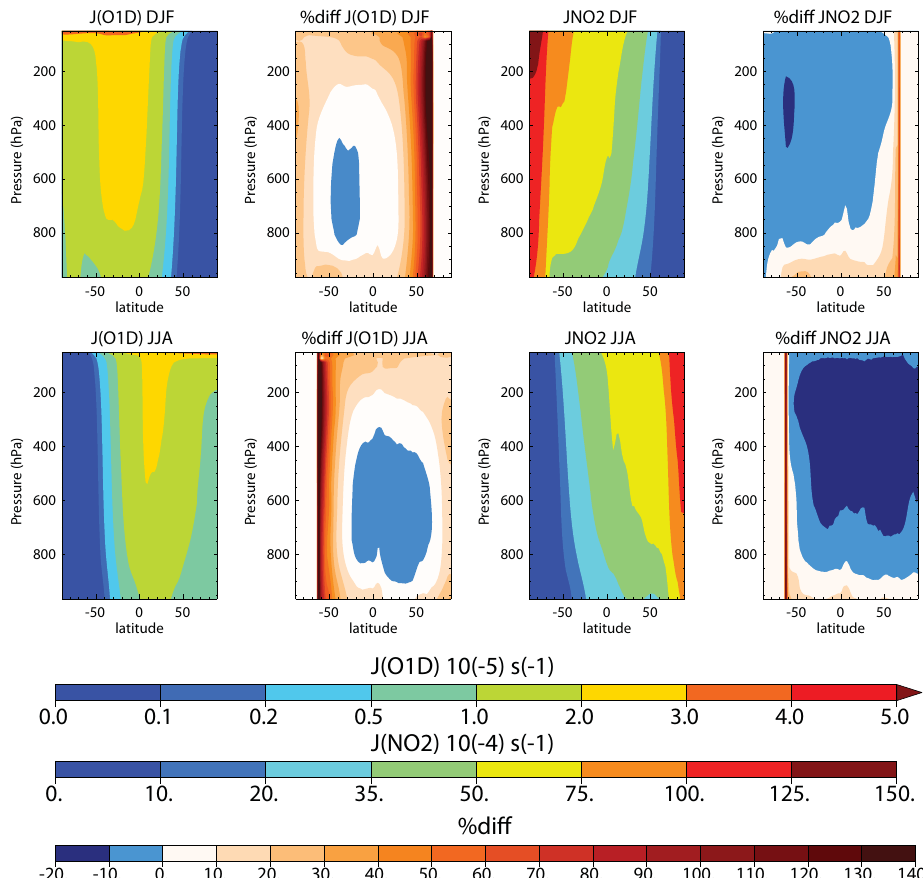
Fig. 1. The seasonal zonal mean vertical profiles of J ing relative differences are shown versus the BA, where the difference is calculated as (MBA-BA)/BA ×